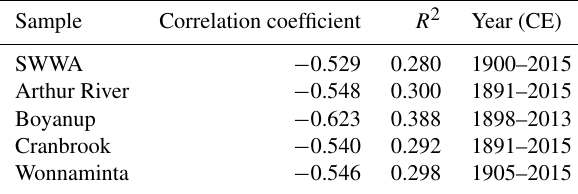
Table 3. The Pearson correlation coefficients for SWWA rainfall and the four BoM stations’ rainfall with the DSS snow accumula- tion. R 2 is the square of the correlation coefficient. All of the corre- lations are statistically significant (6-year window, p <